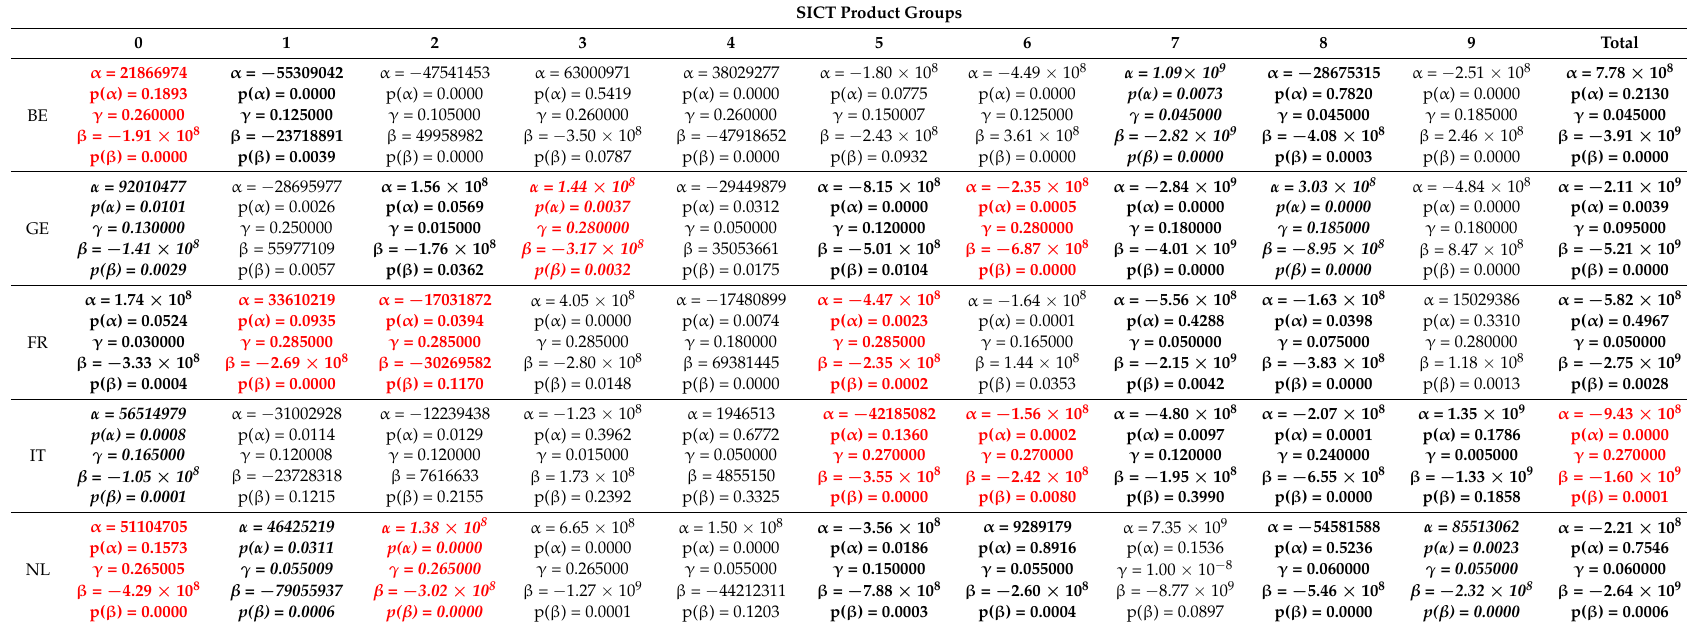
Table A8. Hysteresis with a constant play